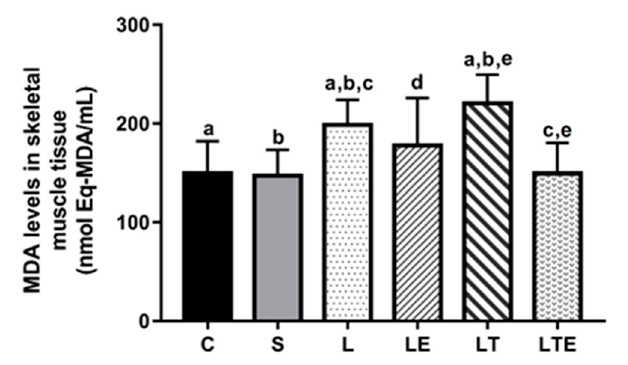
Figure 6. Assessment of MDA levels in the right gastrocnemius muscle. Malondialdehyde (MDA) levels (nmolEq-MDA / mL) in the gastrocnemius muscle after interventions in the di ff erent groups: C, control group; S, sham group; L, injury group; LE, injury + extract group; LT, injury + training group; LTE, injury + training + extract group. Values are expressed as mean ± standard deviation ( n = 10 in each group). The letters “a”, “b”, “c”, “d” and “e” when repeated indicate statistical di ff erences between the groups as determined by one-way ANOVA with Bonferroni post-hoc correction.